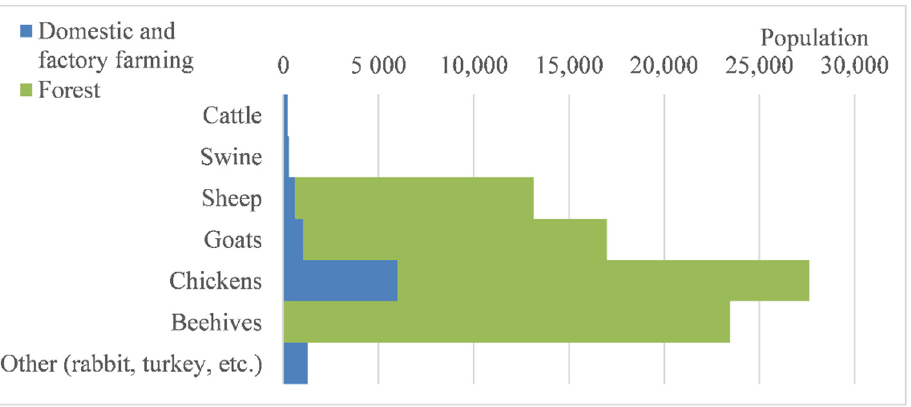
Figure 20. The livestock and the beehives of the municipalities of Istiaia–Edipsos and Mandoudi–Agia Anna–Limni by the census 2019 [90].